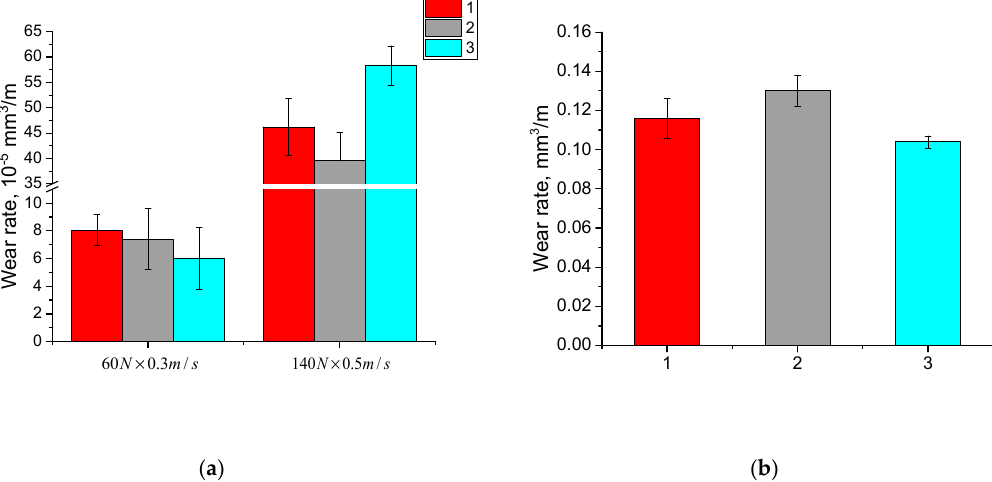
Figure 5. Diagrams on friction coefficients vs sliding distance during tribological tests ( a ) and its average values ( b ): 1—neat GUR 2122; 2—neat GUR 4120; 3—neat GUR 4022-6.